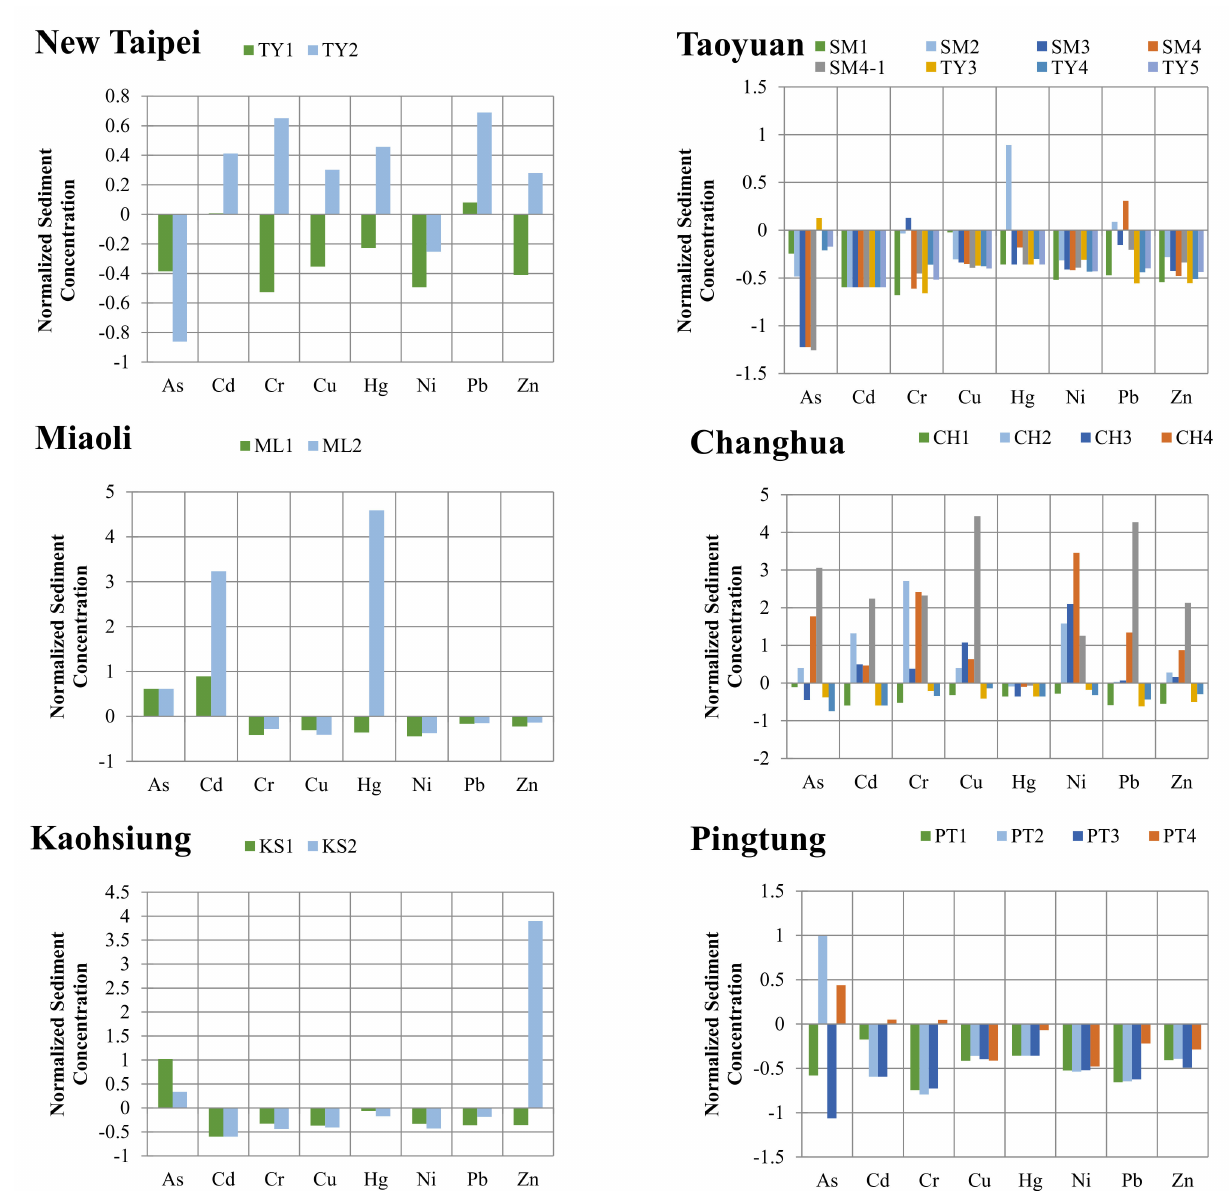
Figure 4. Bar charts of pollutants and concentrations of 25 sediment pollution sites. Agricultural land pollution site characteristics for each county and city are summa- rized in Table 2. The agricultural land pollution sites were located mainly in Taoyuan (47%) and Changhua (45%). In the heavy metal pollutant patterns, most sites contained Cu pollution, totaling 3341 sites (59.8%), followed by pollution sites containing Cr, Cu, Ni, and Zn (10.8%) and the pattern of Cu and Zn (7.9%). The aforementioned three patterns accounted for nearly 80% of the agricultural land pollution sites. In addition to Cr, Cu, Ni, and Zn, pollutants including Cd, Pb, As, and Hg were identified in low